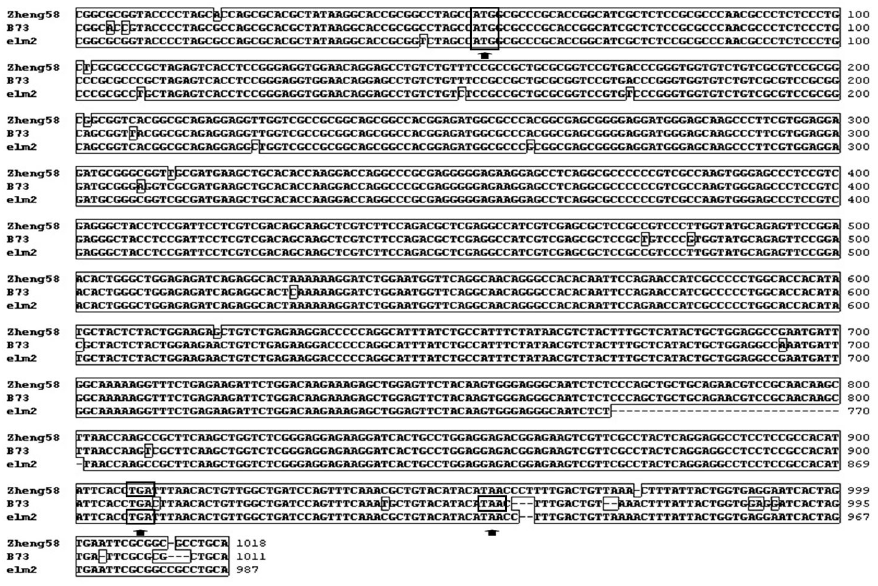
Figure 6. Sequence alignment of HO1 homologs from elm2 , B73 and Zheng58. The start (ATG) or stop (TGA/TAA) codons are enclosed with boxes. The dotted lines indicate the 31 bp deletion present in elm2 . Clustal X software was used for the sequence